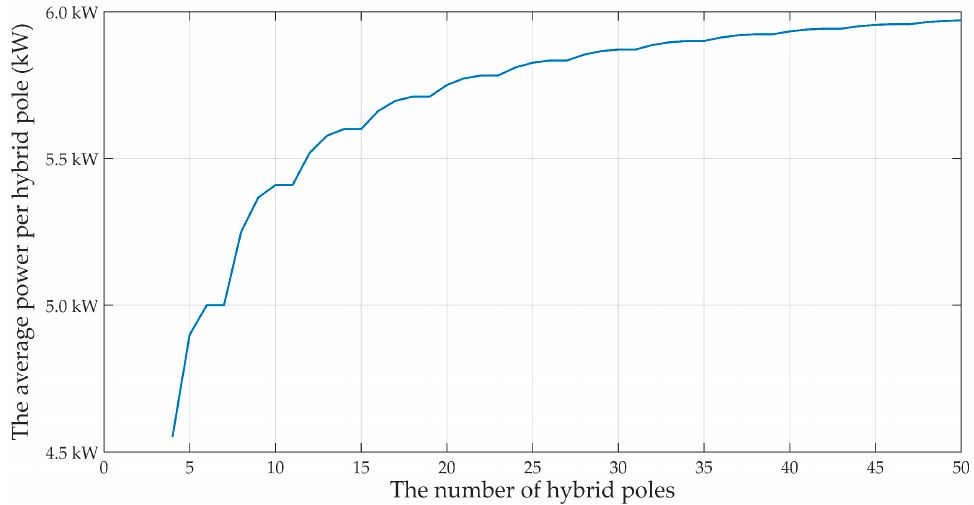
Figure 8. The functional image of average power per hybrid pole under uniform distribution.